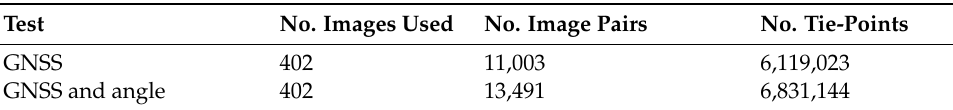
Table 6. Statistic for tie-point